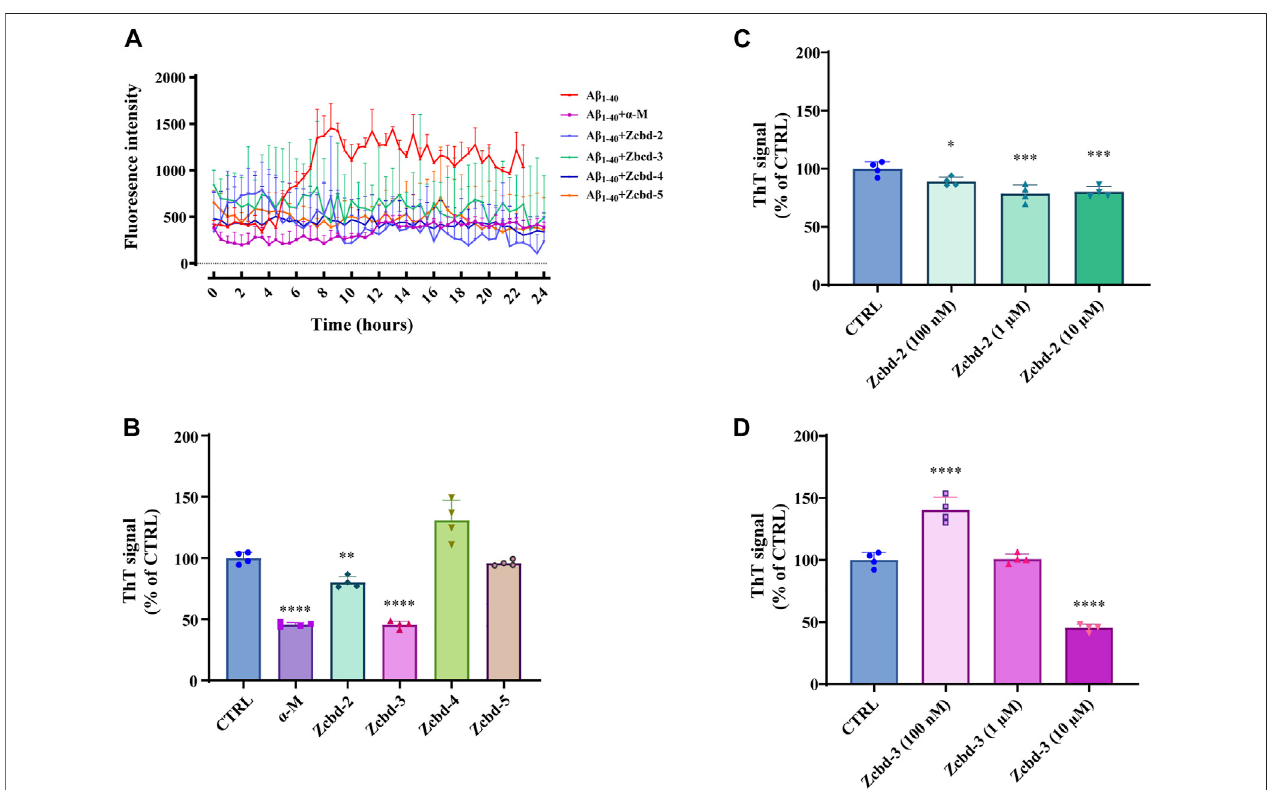
FIGURE2| α -ManditsanaloguesinhibitedA β fi brillogenesis (A) Inhibitoryeffectsof α -ManditsanalogueseffectonA β fi brilformation24 hkineticdetection.10 μ M of ThT was incubated with A β 1-40 or the mixture of A β 1-40 and α -M or its analogues at 37 ° C. The newly formed fi brils were measured by a 24 h continuous ThT fl uorescence at 30 min intervals (B) Disaggregation of preformed A β fi brils by α -M and its analogues. A β fi rstly incubated at 37 ° C for 48 h. Then α -M or its 1-40 was analogues were added and incubated for another 8 h. ThT was subsequently added into the mixture with a fi nal concentration of 10 μ M. The fl uorescence was monitored with excitation at 446 nm and emission at 490 nm (C) and (D) Dose-effect relationship in the disaggregation of preformed A β fi brils by Zcbd- 2 and Zcbd- 3